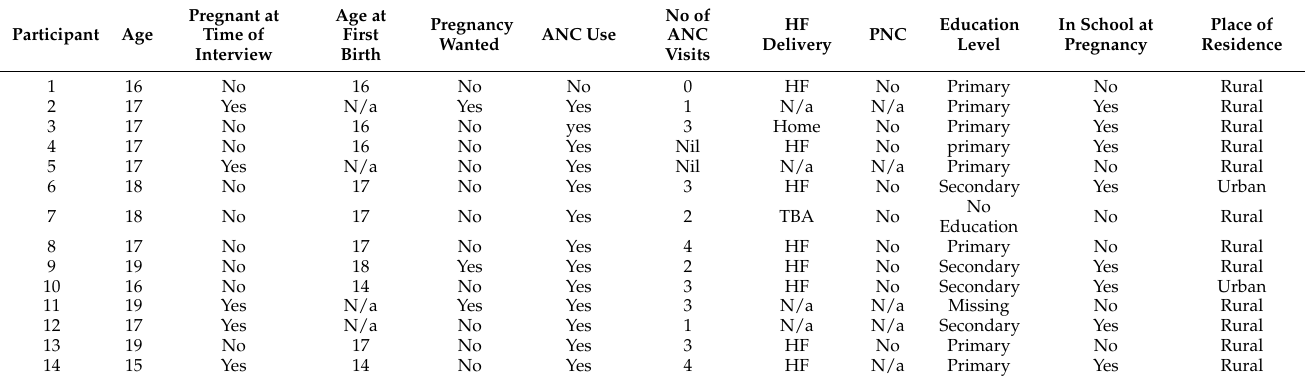
Table 4. Summary of youth in-depth interview participants’